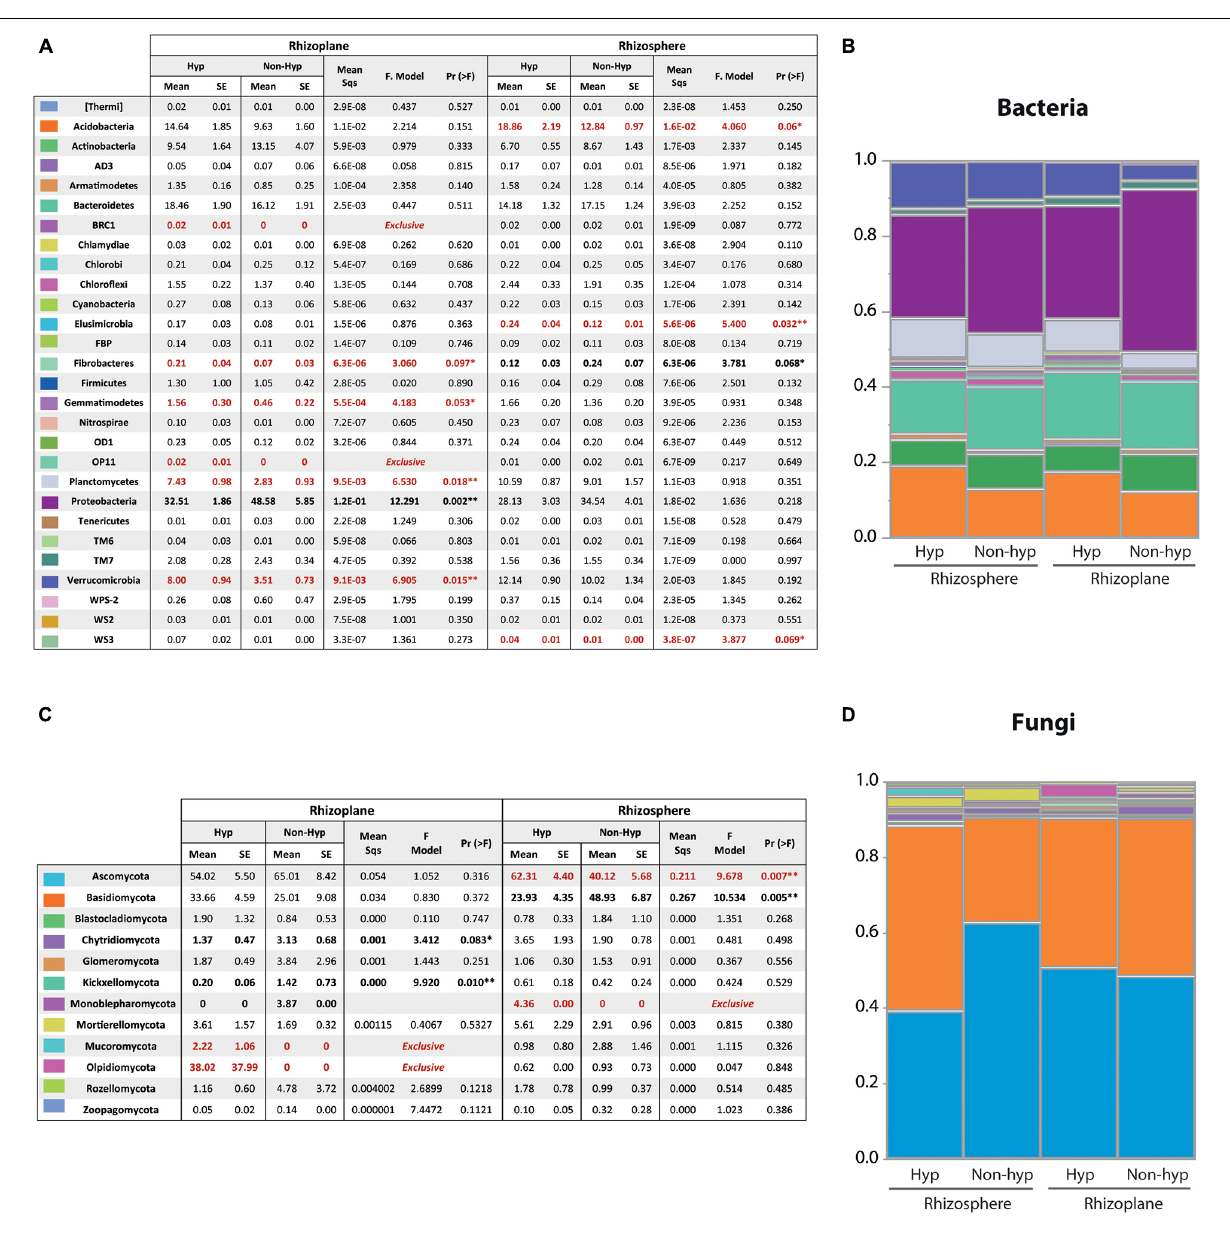
FIGURE 5 | Bacterial and fungal community composition and relative abundance. (A) Means and standard errors (SE) of the relative abundances of the bacteria domain at phylum level. Differences and summarized results of an ANOVA pairwise comparison between N. brachypetala and non-hyperaccumulators at each soil compartment were calculated by the log2 ratio. (B) Bacterial relative abundance at the phylum level in a staked plot. The x axis indicates root compartment and plant genotype. (C) Means and standard errors (SE) of the relative abundances at phylum level on the fungi domain. Differences and summarized results of an ANOVA pairwise comparison between N. brachypetala and the non-hyperaccumulators at each soil compartment calculated by the log2 ratio. (D) Fungal relative abundance (at the phylum level) in a staked plot. The x axis indicates the root compartment and plant